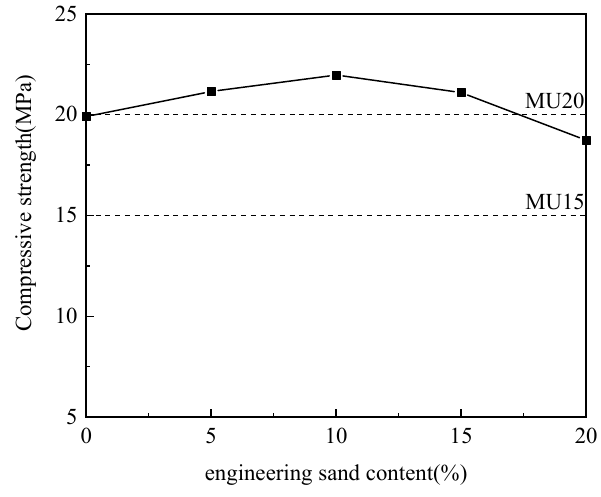
Figure 7. Effect of engineering sand content on compressive strength.